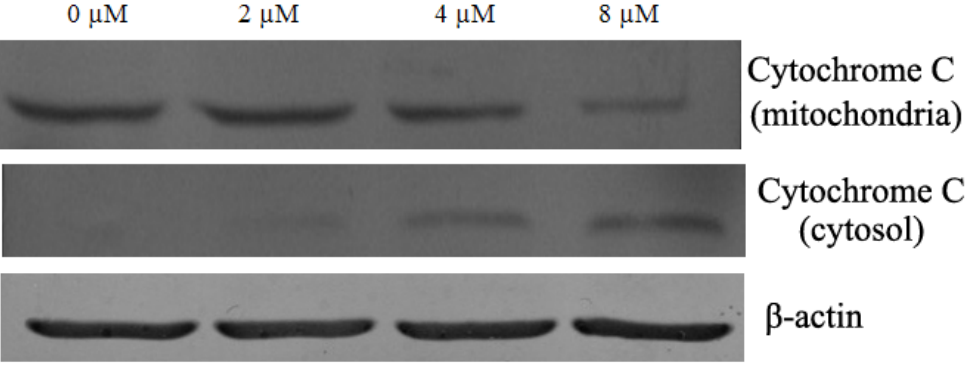
Figure 7. Chamaejasmine -induce cytochrome c release by western blotting assay, A549 cells were treated with chamaejasmine (0, 2, 4, 8 µM) for 48 h, respectively. These figures are one representative experiment of three with similar results. β -actin served as a loading control.